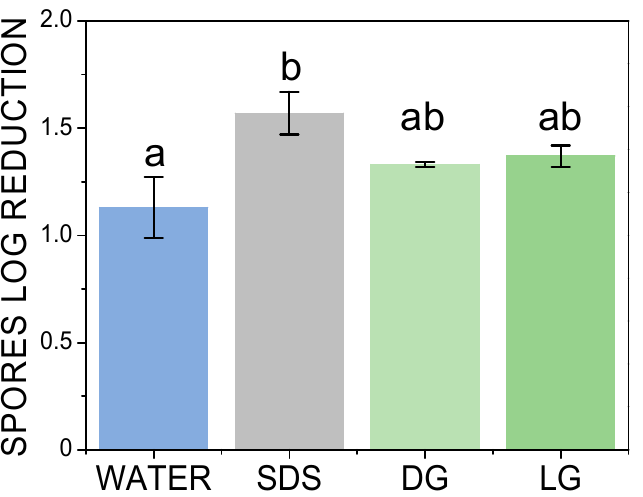
Figure 1. Spores log reduction on the plate under static dipping conditions as a function of the surfactant in comparison to water. The small letters a–b indicate groups of statistical differences according to Tukey’s test ( p < 0.05).